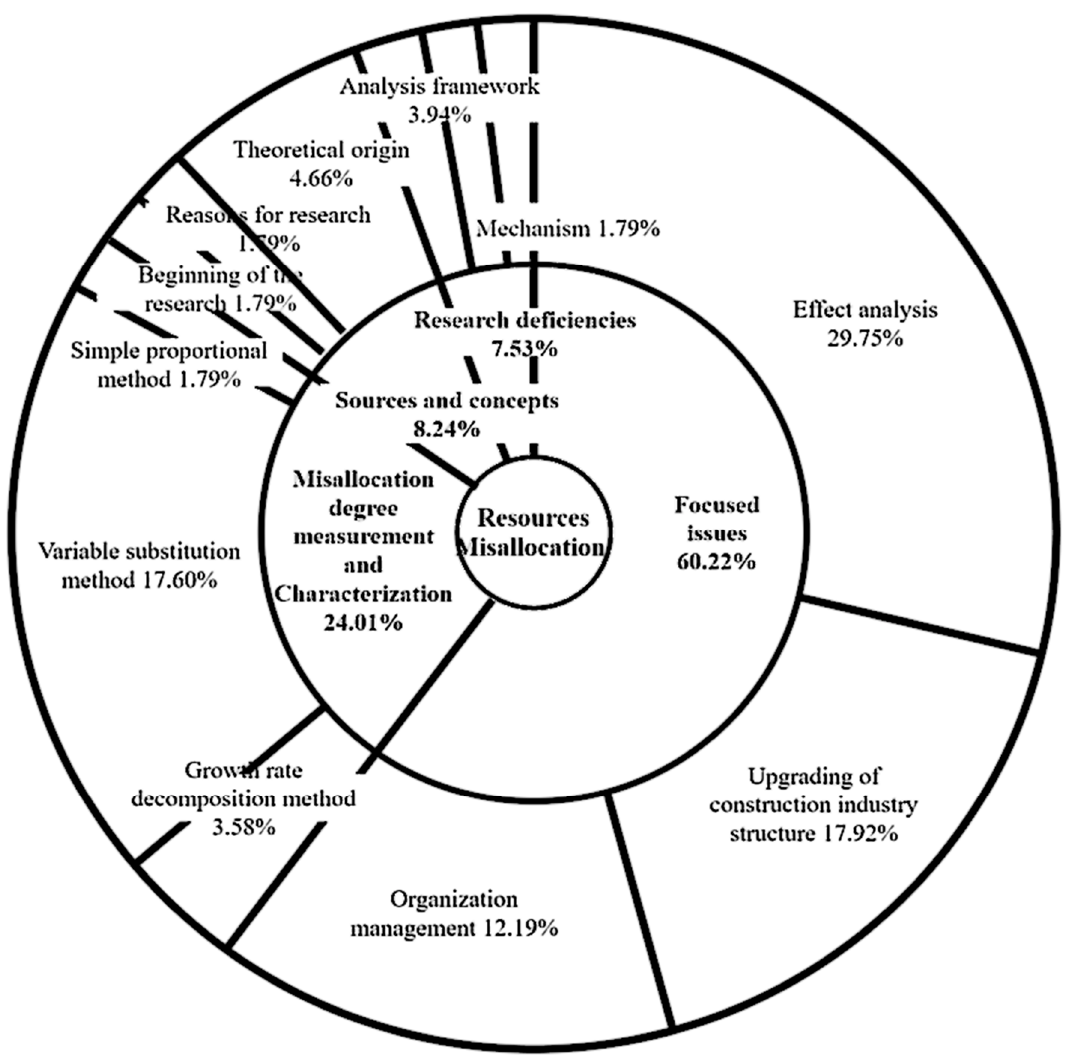
Figure 4. Structural model for RM analysis. Second-level nodes are outside. First-level nodes are inside.